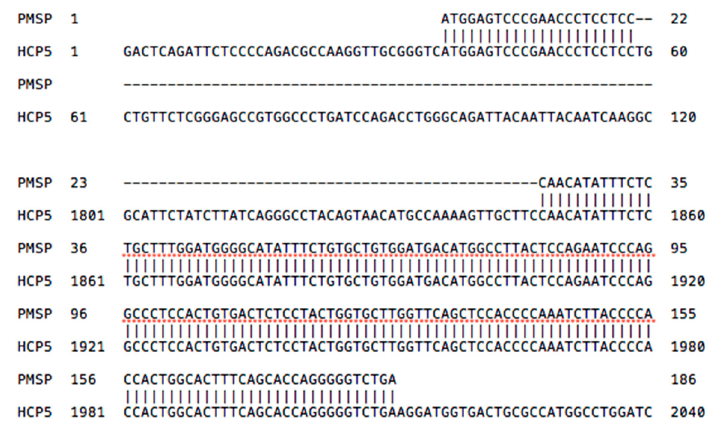
Figure 2. DNA nucleotide alignment between the papillomavirus minor structural protein (PMSP) (AJ437509.2) and HCP5 RNA sequence